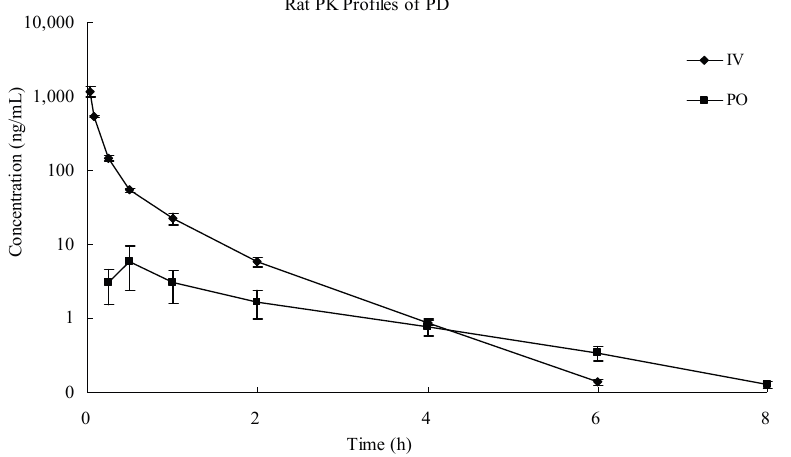
Figure 4. Mean plasma concentration-time profiles of PD determined by LC-MS/MS method after intravenous and oral administration to rats. Each point represents mean ± SD ( n = 3).